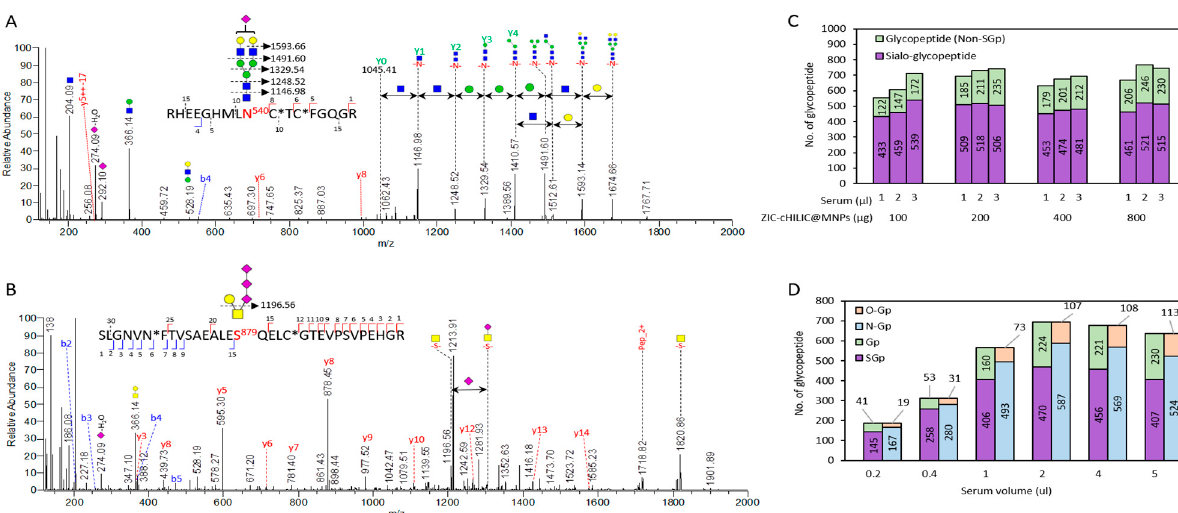
Figure 4. Identification of intact sialylated glycopeptides from HCC serum sample. ( A ) Representative MS/MS spectrum of identified intact N-glycopeptide RHEEGHMLNCTCFGQGR from FN1 protein with mono-sialyl-bi-antennary glycan ( m / z 1001.40, z = 4+, Byonic score = 269.1). ( B ) intact O-glycopeptide SLGNVNFTVSAEALESQELCGTEVPSVPEHGR from A2M ( m/z 1164.02, z = 4+, Byonic score = 1108.5). ( C ) Number of identified glycopeptides for optimization of ZIC-cHILIC@MNPs particle amount, injection sample amount, and ( D ) HCC serum volume.